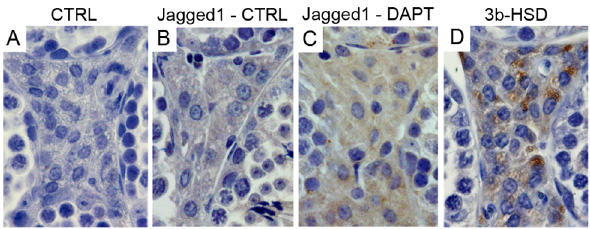
Figure 3. DAPT treatment disrupts Jagged1 expression in testis interstitial Leydig cells . Positive staining in brown, counterstaining with haematoxylin (400x magnification). Control (CTRL) slides used rabbit IgG (A). Jagged1 is not expressed in Leydig cells of control mice (B), but becomes expressed following DAPT treatment (C). Leydig cells are co-localized in twin slides with marker 3 b -HSD (D).